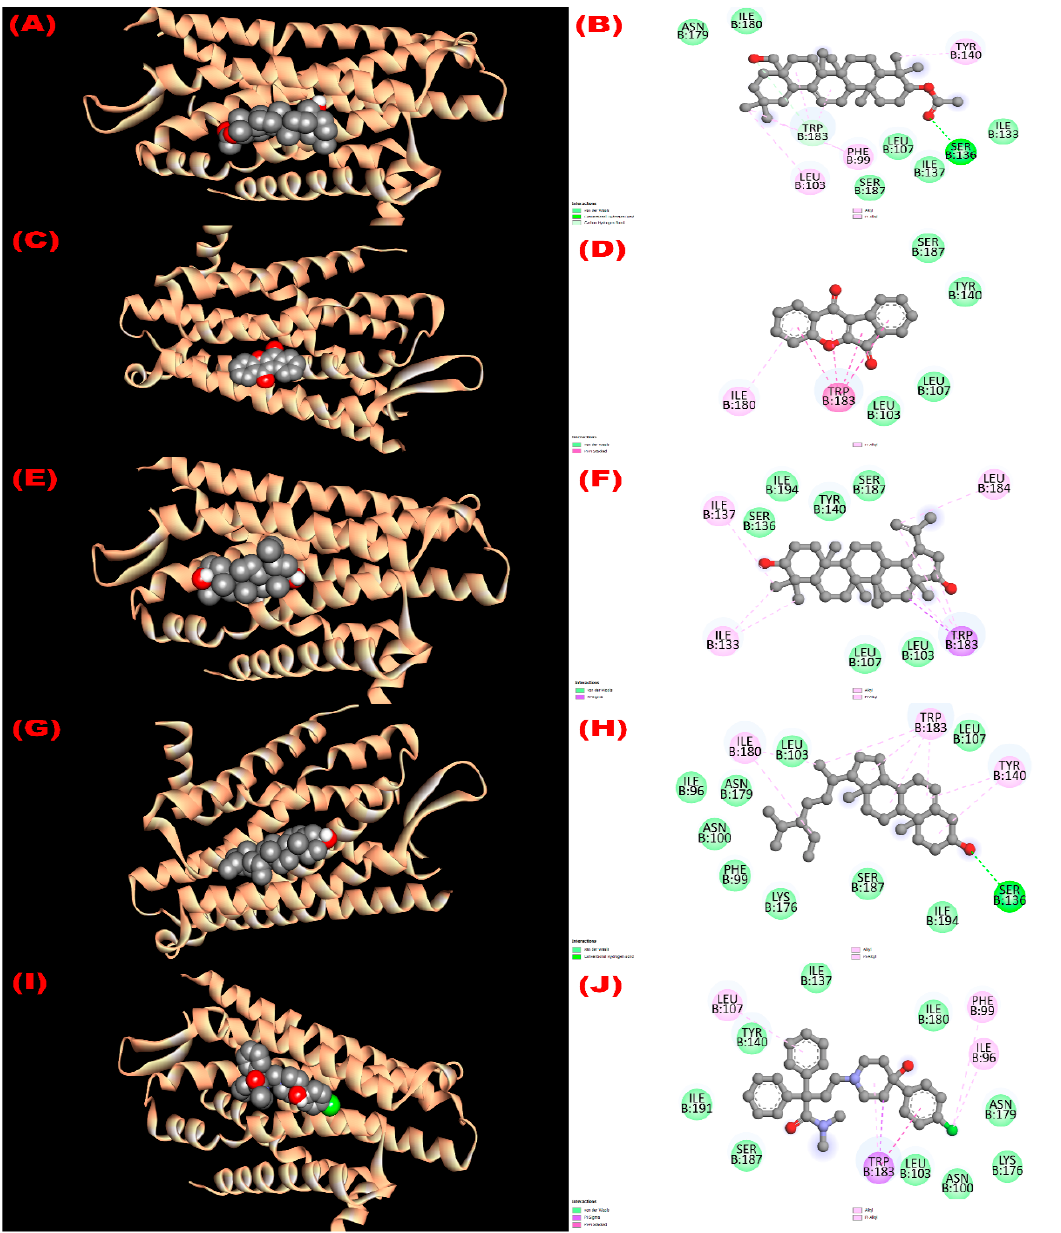
Figure 4. The 3D and 2D view of molecular interactions of the isolated compounds with the kappa opioid receptor (PDB ID: 6VI4) revealing the antidiarrheal activity. (( A , B ), ( C , D ), ( E , F ), ( G , H ), ( I , J ) sketched the pictorial view of molecular interactions of compounds ( 1 to 4 ) 3 β -acetyloxy-olean-12-en-28-ol, Wrightiadione, 22 β -hydroxylupeol, β -sitosterol, and the standard loperamide, respec- tively).